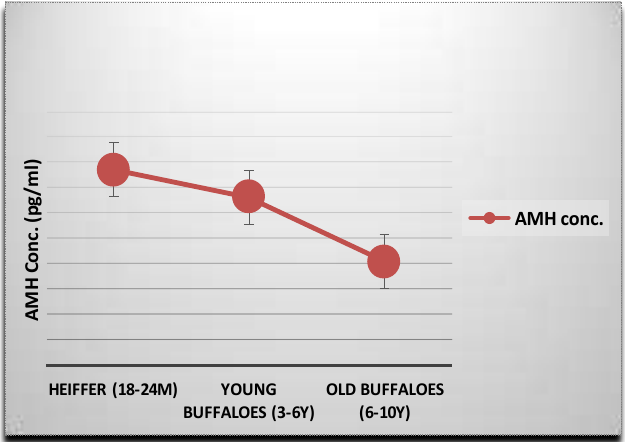
Fig. 1: Concentration of serum AMH in heifer, young and old buffaloes on day 0.